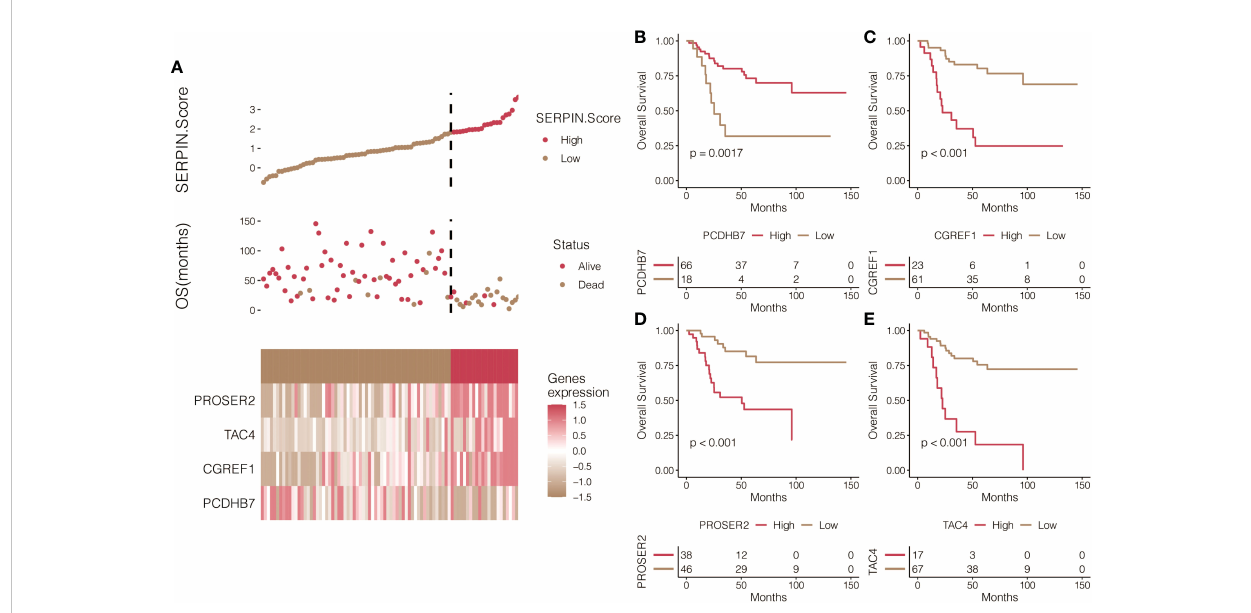
FIGURE 7 Prognostic value of the SERPINH1-related score. (A) The expression patterns of PCDHB7, TAC4, PROSER2, and CGREF1 in two SERPINH1-related score-strati fi ed groups. (B) Survival curves of the two PCDHB7-strati fi ed, (C) TAC4-strati fi ed, (D) PROSER2-strati fi ed, and (E) CGREF1-strati fi ed